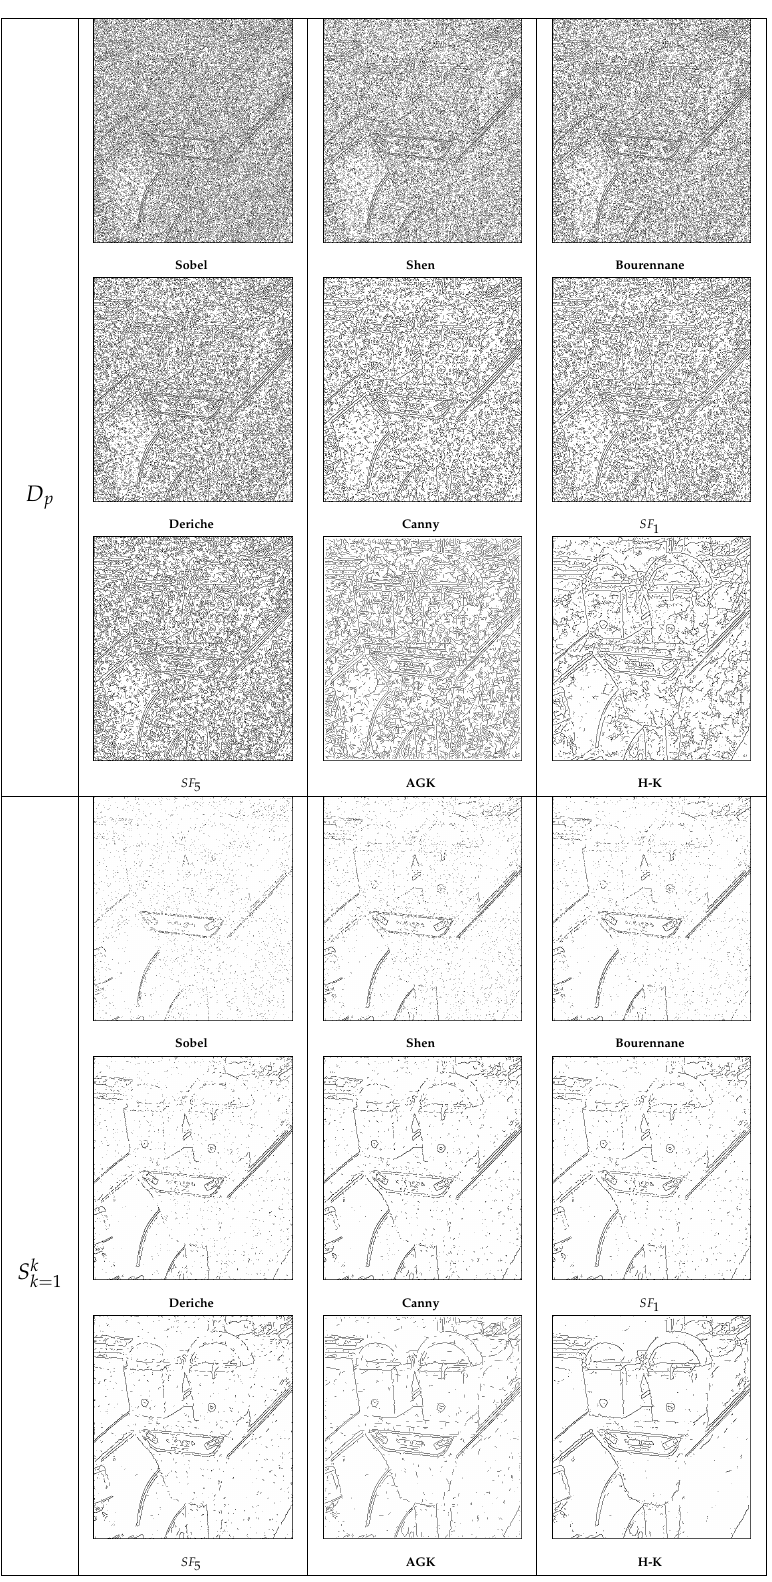
Figure 45. Ideal segmentations for several edge detectors on image parkingmeter, PSNR = 14